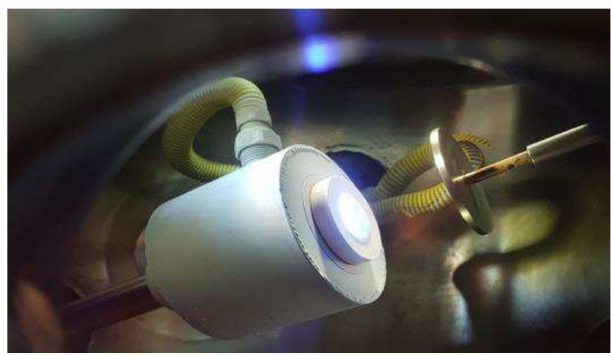
Figure 7. Representative MAPLE frozen